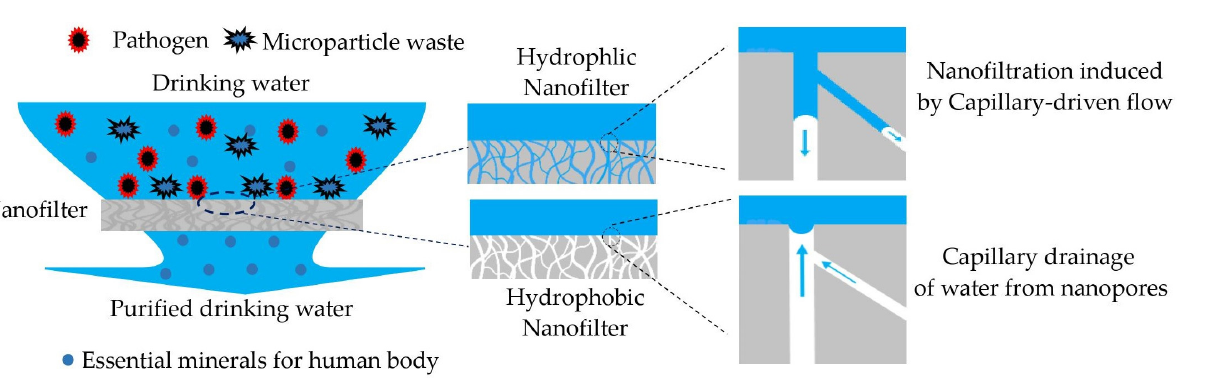
Figure 1. Schematic illustration of capillary-driven NF principle for r p << λ c .